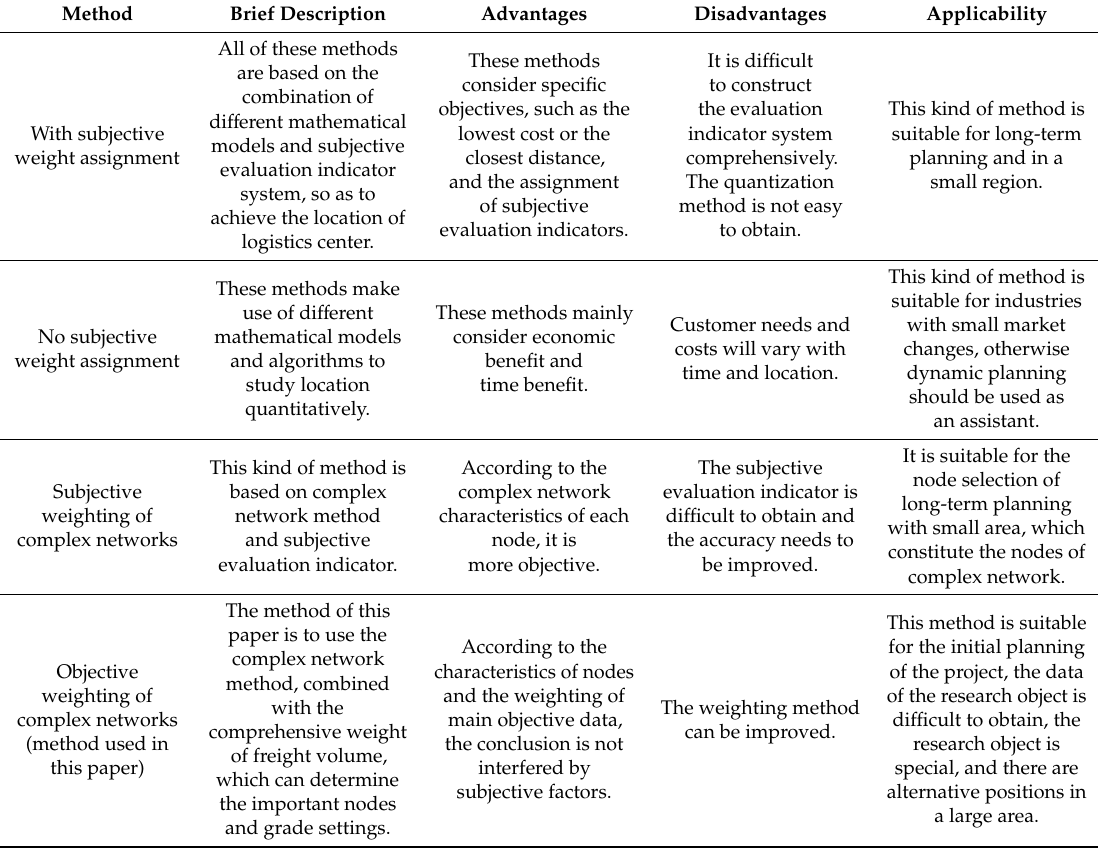
Table 14. Comparative analysis with previous